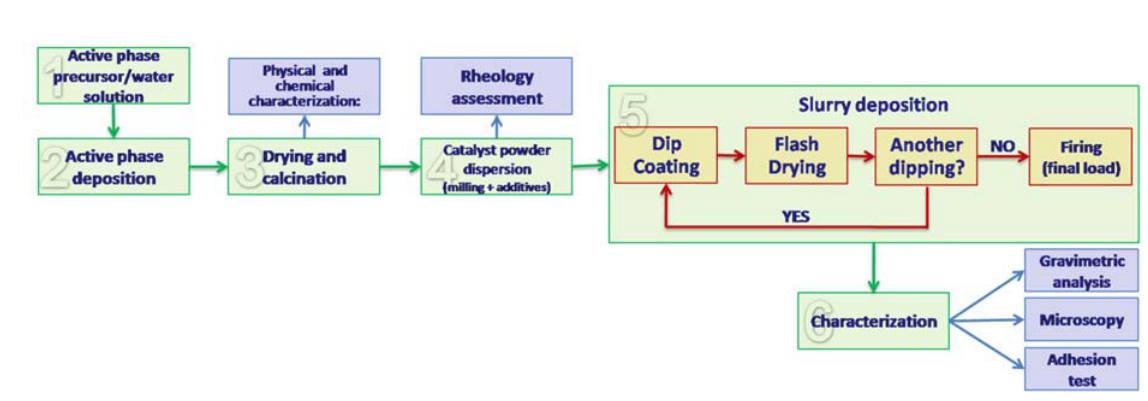
Figure 10. Scheme for catalyst production and washcoat deposition (slurry composition and details of the procedures as reported